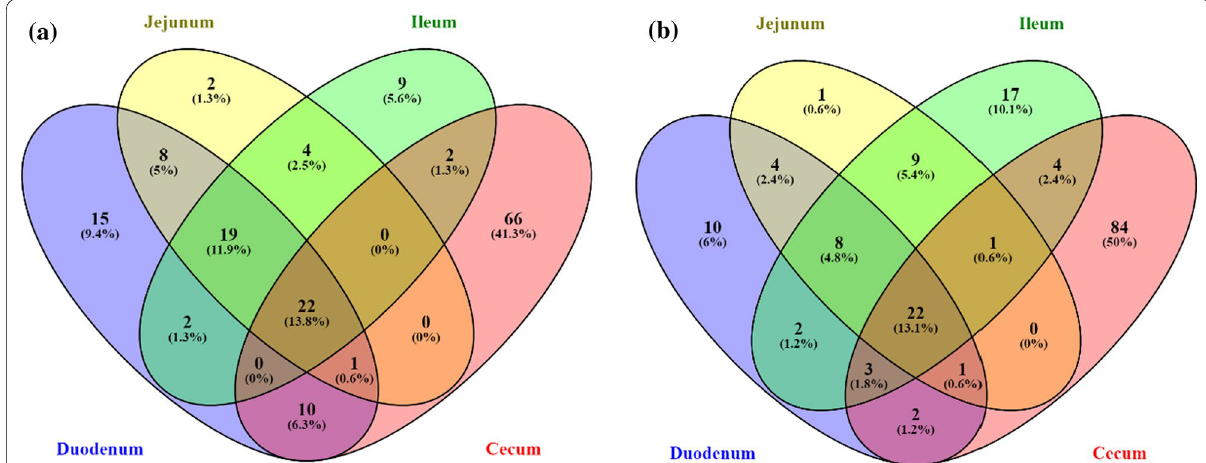
Fig. 4 a , b Venn diagram showing common and shared species-level OTUs within each GI tract section for both control and MRF supplemented broilers (99% sequence